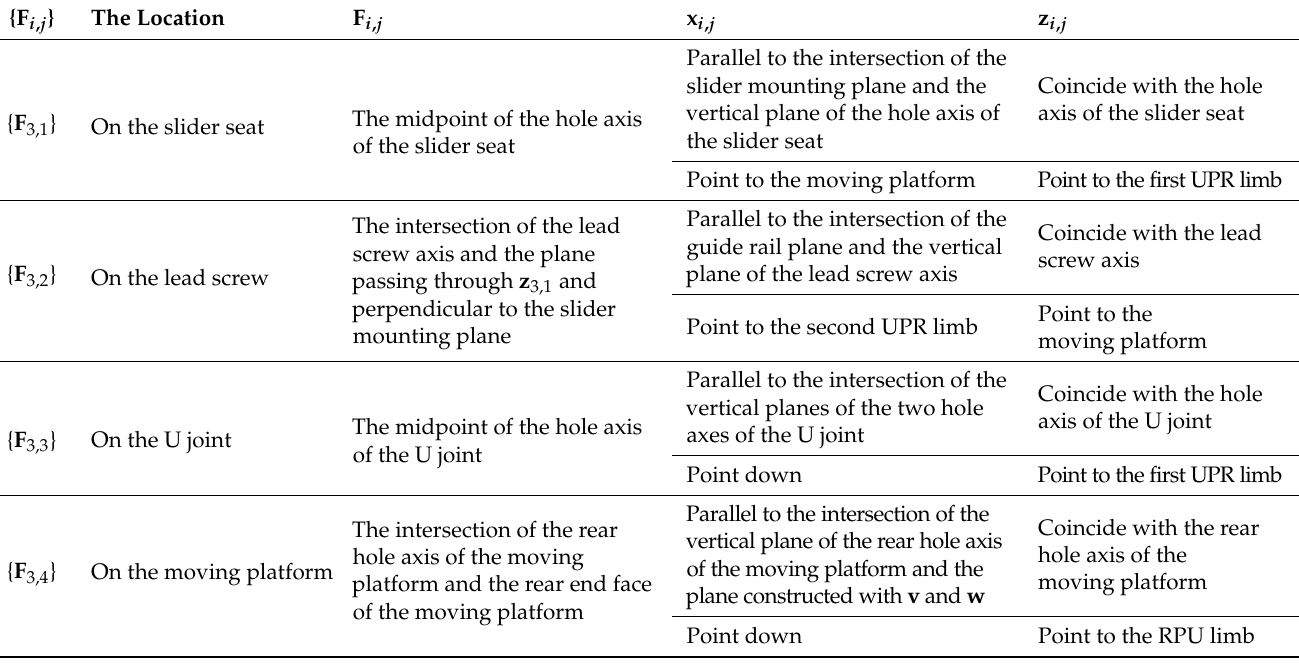
Table 3. Definitions of local coordinate systems for the RPU